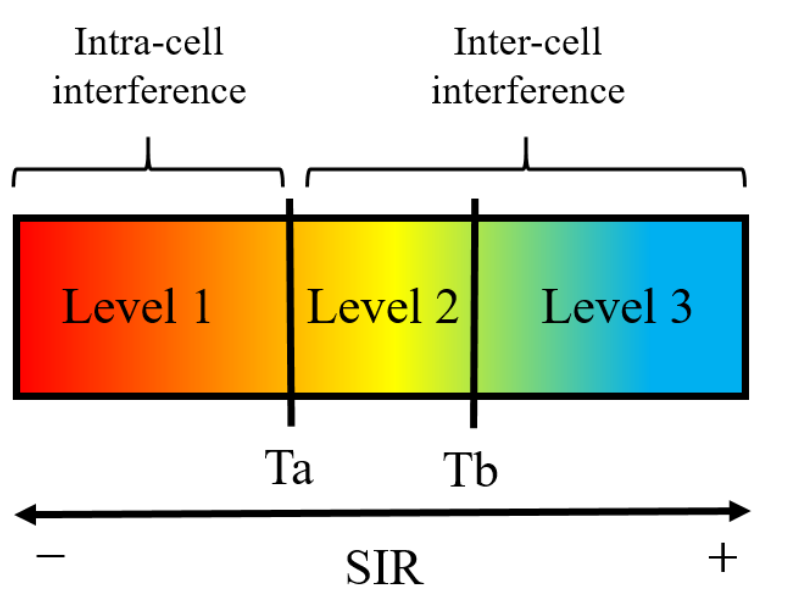
Figure 2. Different levels of signal-to-interference ratio (SIR) during up-link transmission between user k and BS j